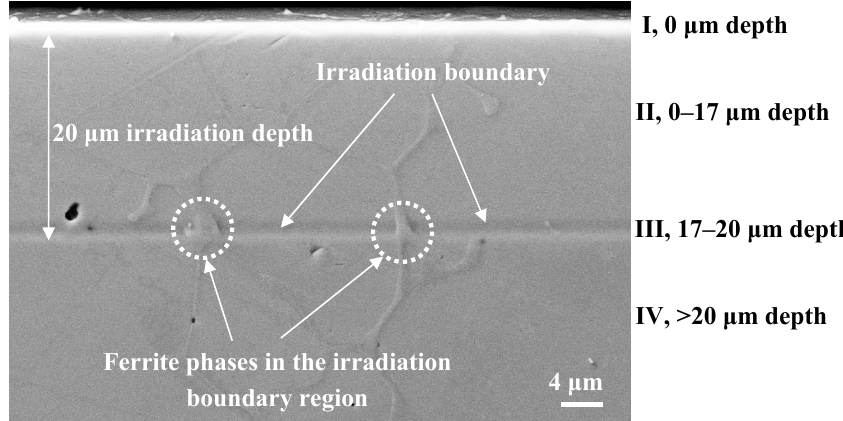
Figure 3. SEM image of the irradiated sample cross-section after colloidal silica slurry polishing including five regions: irradiated surface region I, uniform damage region II, maximum damage region III, and unirradiated region IV along the depth direction.